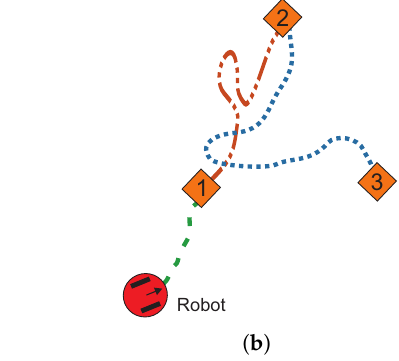
Figure 1. Efficient route and unnecessary turnings for multiple-target problem. ( a ) Efficient path for multiple-target problem. ( b ) Unnecessary turnings in multiple-target path (point-to-point